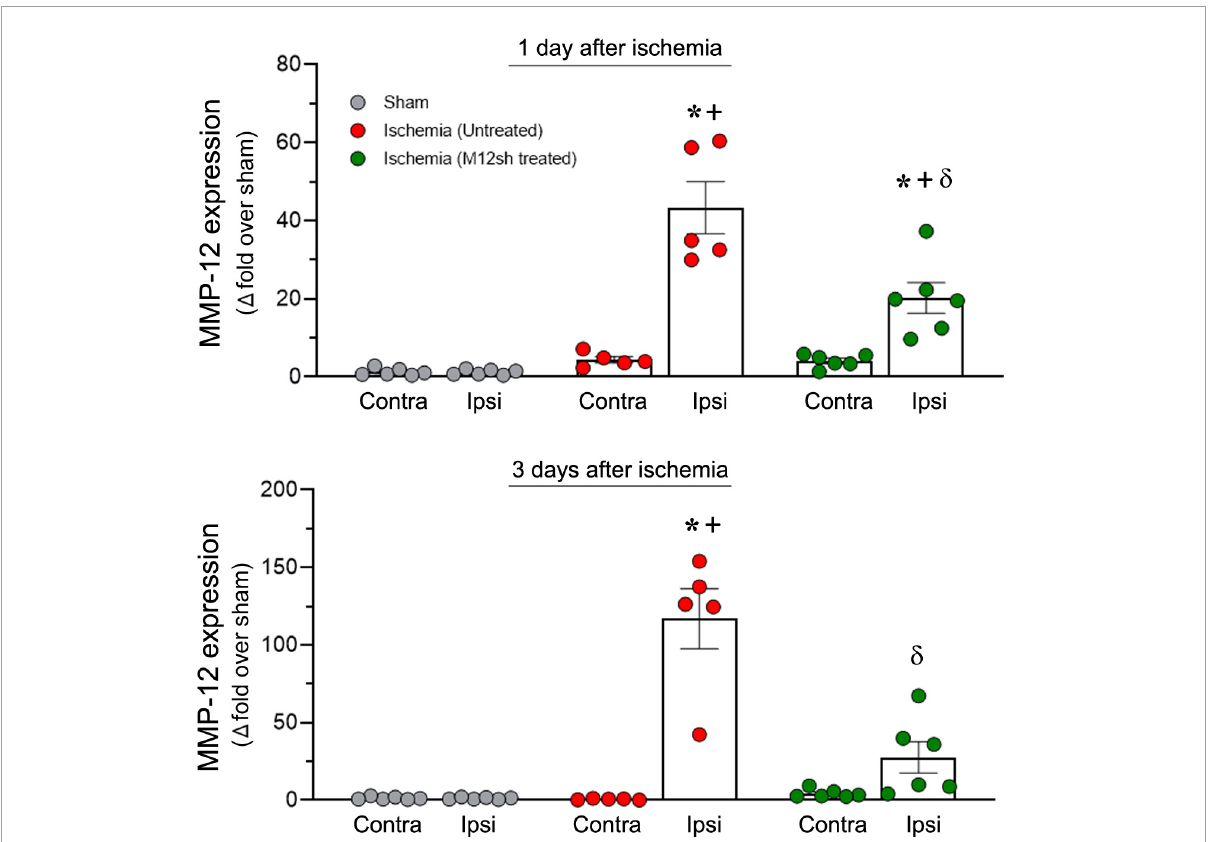
FIGURE2 M12sh treatment is effective in reducing MMP-12 expression in vivo . The column scatter plots show the quantified mRNA expression of MMP-12 (expressed as fold change over sham) on post-reperfusion days 1 and 3 in the contralateral (Contra) and ipsilateral (Ipsi) brain hemispheres of male rats subjected to 2-h transient focal cerebral ischemia. Statistical analysis: Two-way ANOVA followed by Sidak’s/Tukey’s multiple comparisons tests. + p < 0.05 vs. Contralateral brain hemisphere (same experimental group). * p < 0.05 vs. Sham (same brain hemisphere). δ p < 0.05 vs. Ischemia (Untreated) group (same brain